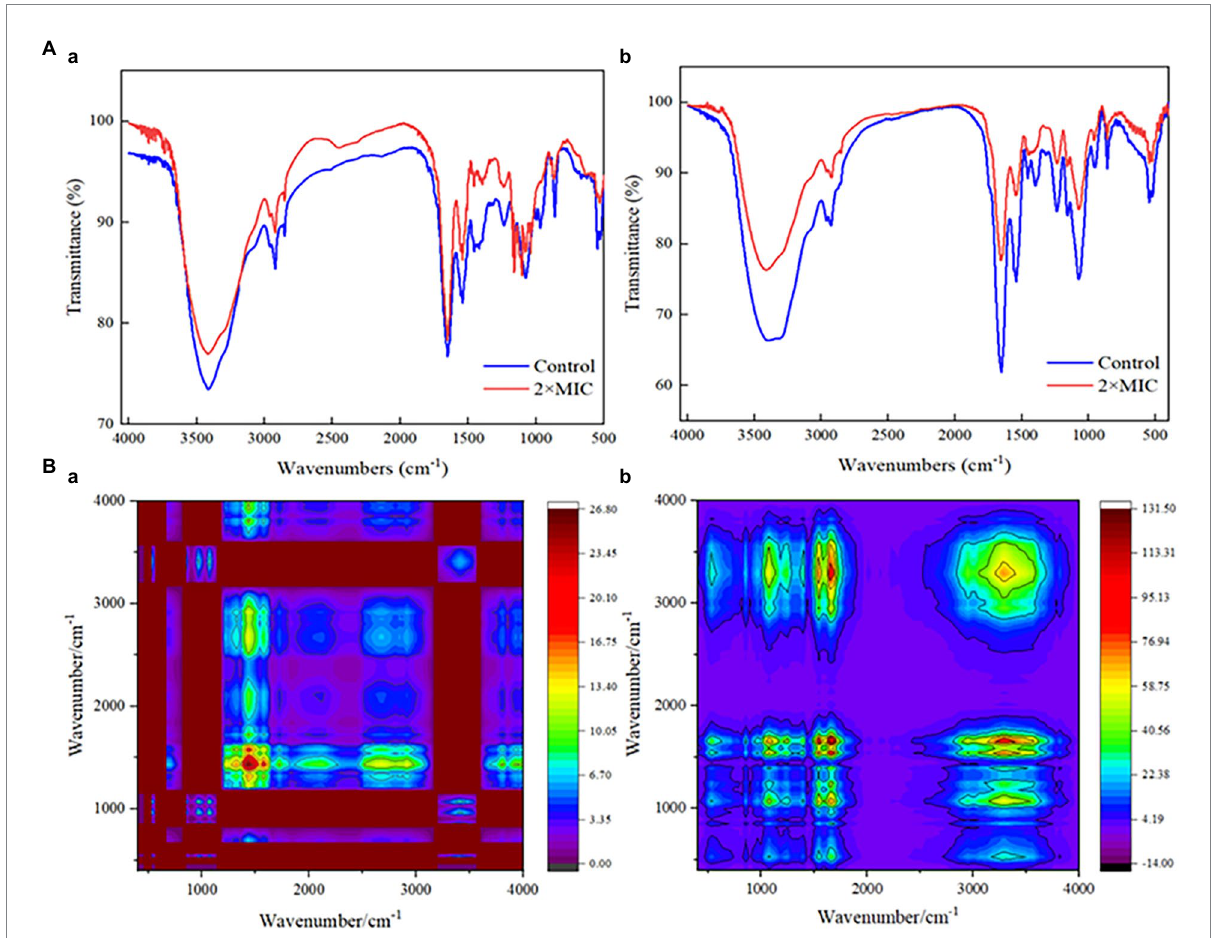
FIGURE 6 FT-IR spectra analysis of S. xylosus and L. plantarum under MDA treatment. A(a) : IR spectra of S. xylosus ; A(b) : IR spectra of L. plantarum ; B(a) : 2DCOS-IR of S. xylosus ; B(b) : 2DCOS-IR of L. plantarum